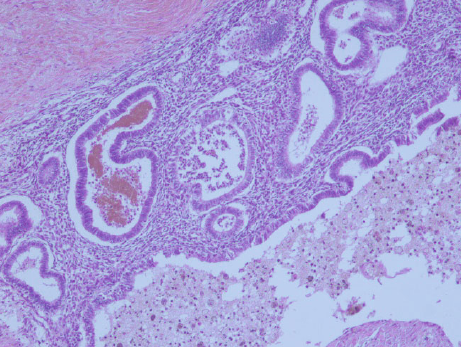
Figure 5: Endometrial glands with hemorrhage and stroma (H&E,